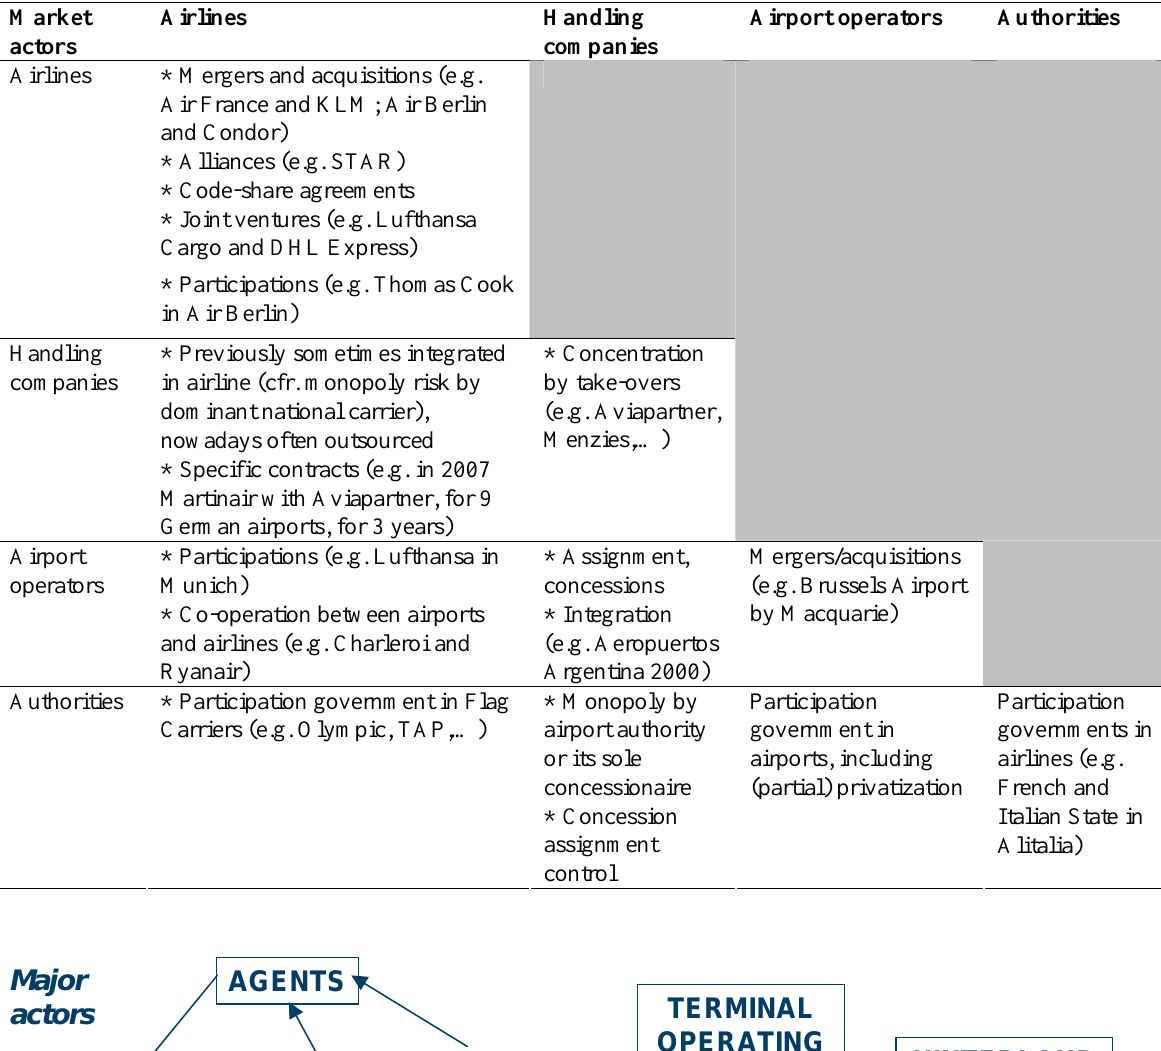
Table 3. Control and cooperation between subsectors in the air transport industry Market